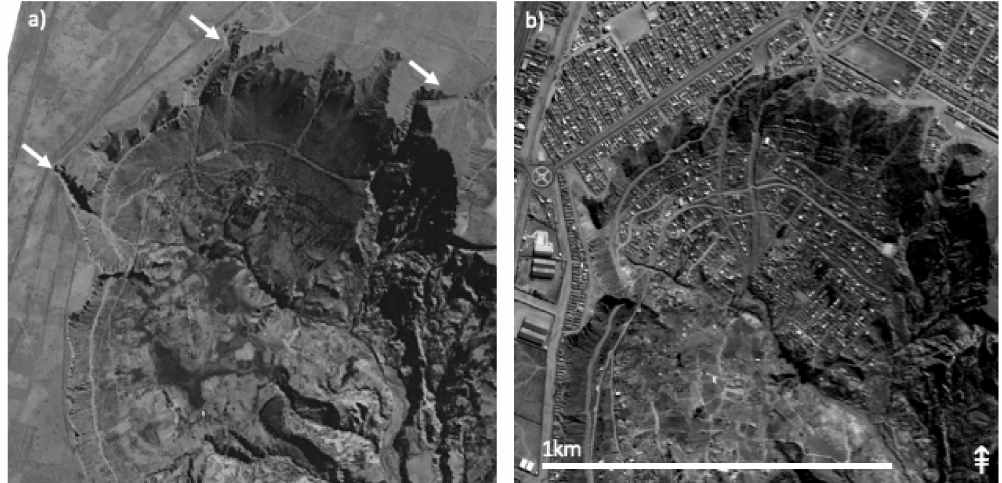
Figure 2. El Alto / La Paz, Bolivia. Area east of the airport in ( a ) 1967 and ( b ) 2004, showing urban growth into steep flanks of a valley (Data: Table